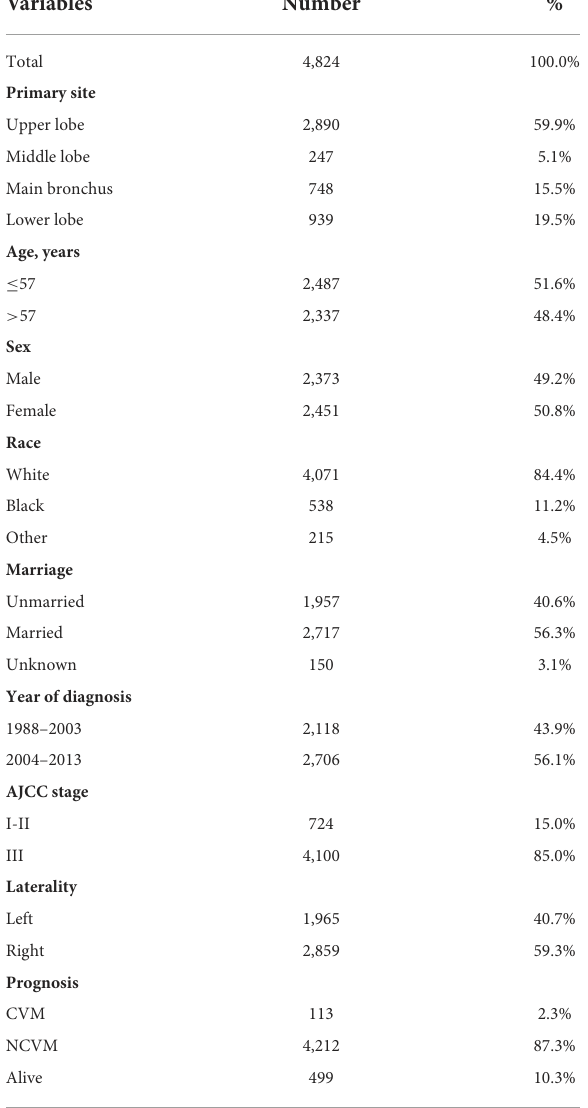
TABLE 1 The baseline clinical and prognostic characteristics of total study